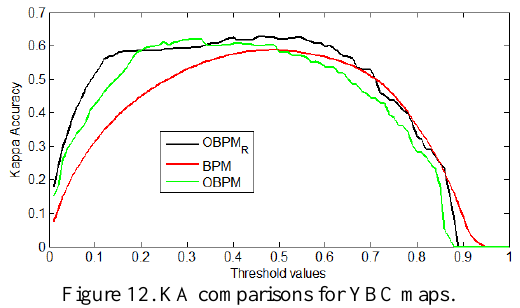
Figure 12. KA comparisons for YBC maps.